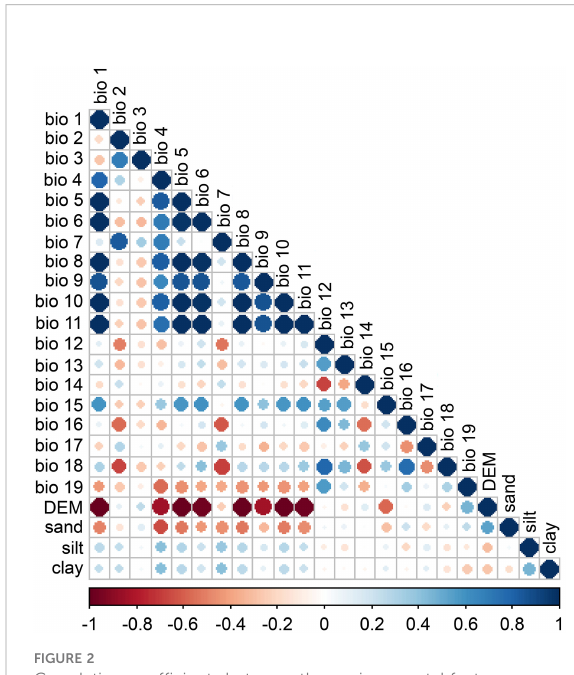
FIGURE 2 Correlation coef fi cients between the environmental factors. Positive correlations are shown in blue and negative correlations are shown in red. The color intensity and the size of the circle are proportional to the correlation coef fi